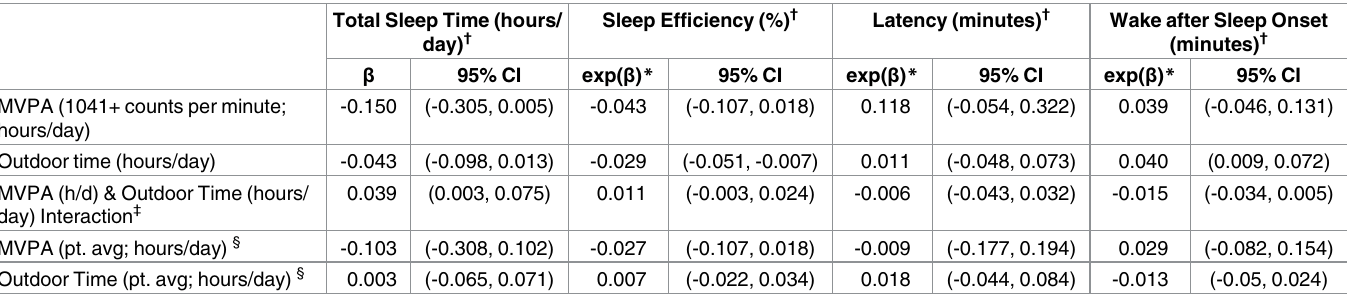
Table 2. The moderation of the relationship between Moderate to Vigorous Physical Activity (MVPA) and sleep by outdoor